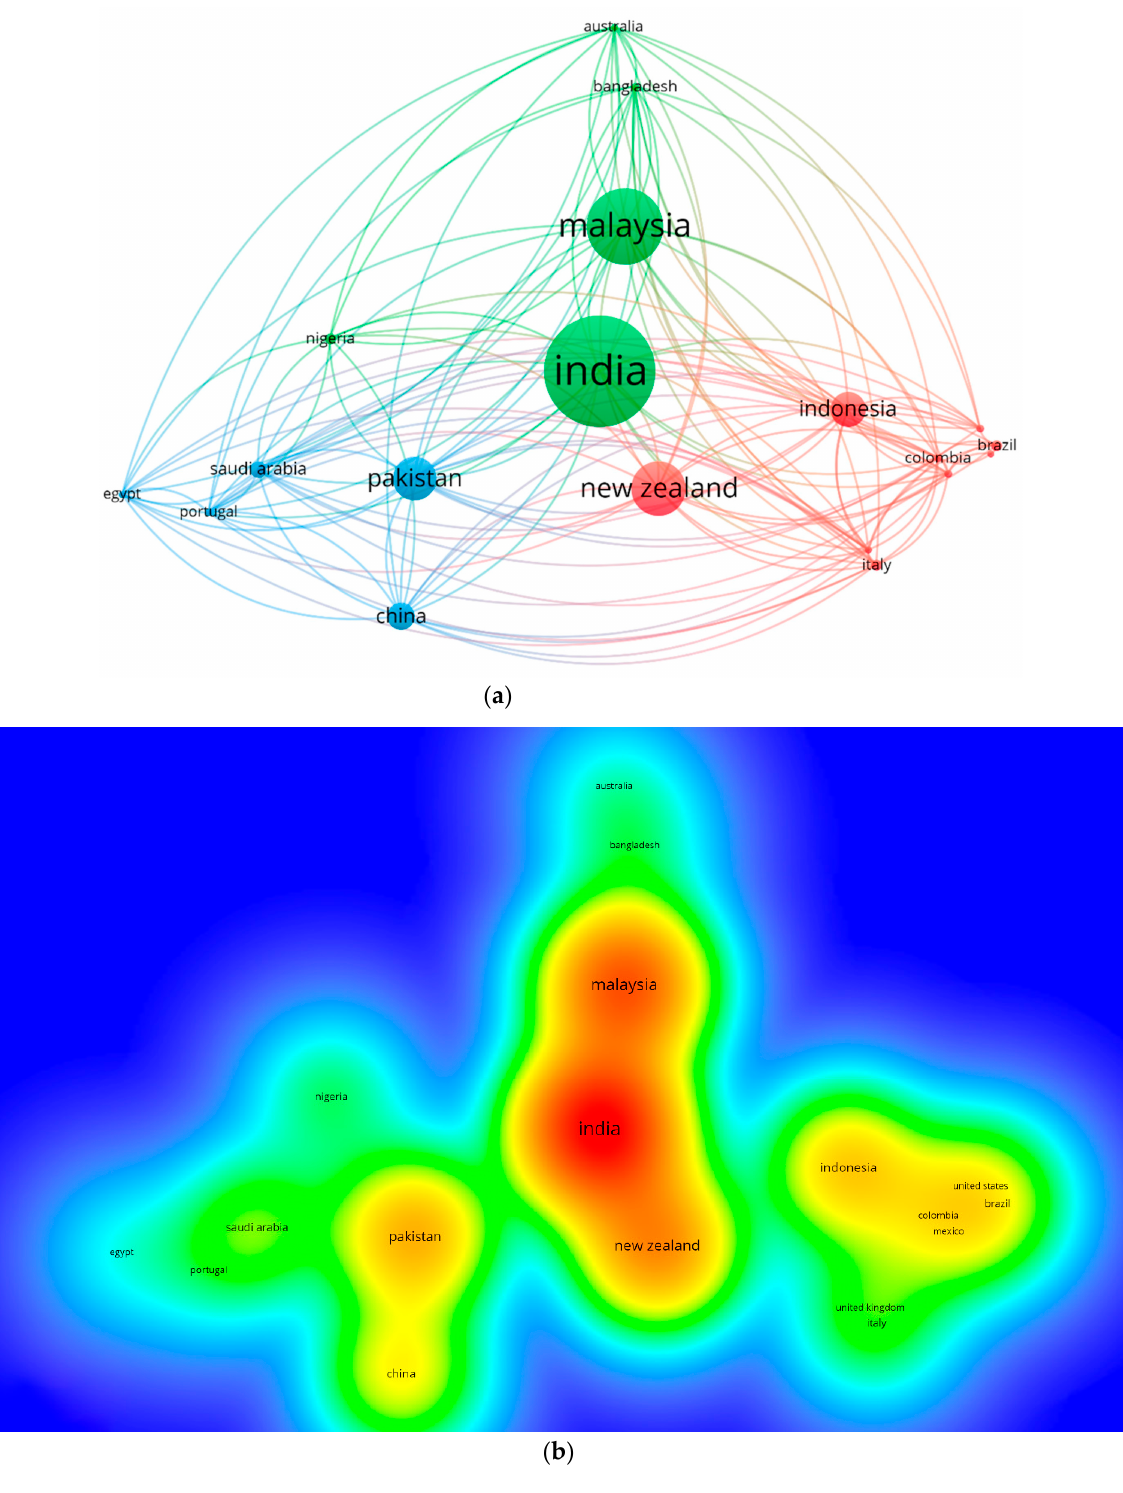
Figure 11. Scientific visualization of countries in the related research area up to 2022: ( a ) Network visualization. ( b ) Density visualization.